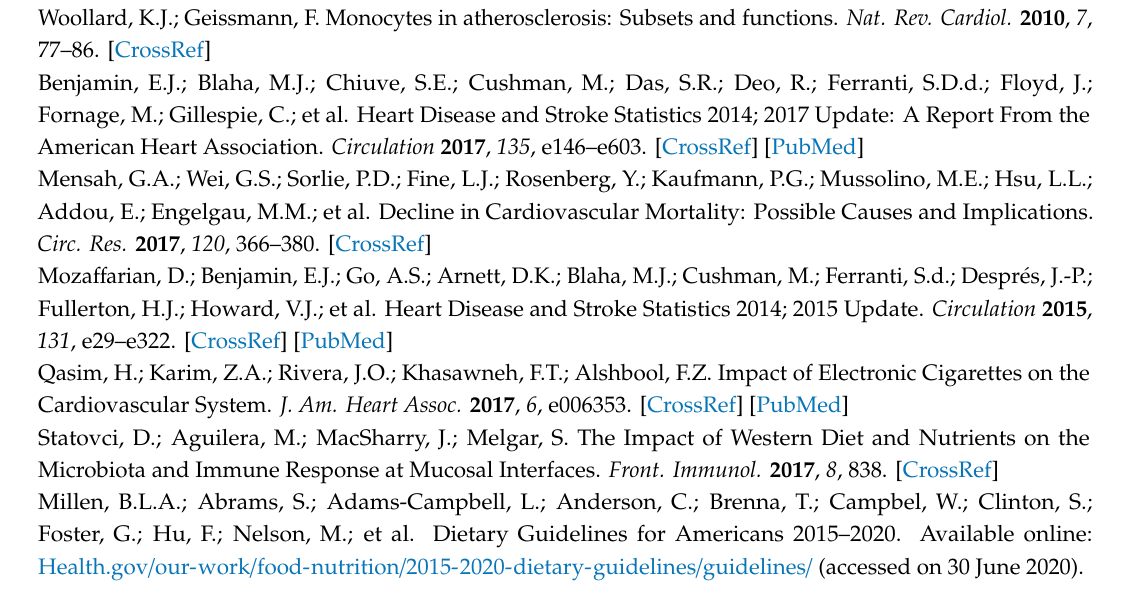
Table S1: Fruits. Table S2: Vegetables. Table S3: Nuts and grains. Table S4: Oils, spices, and